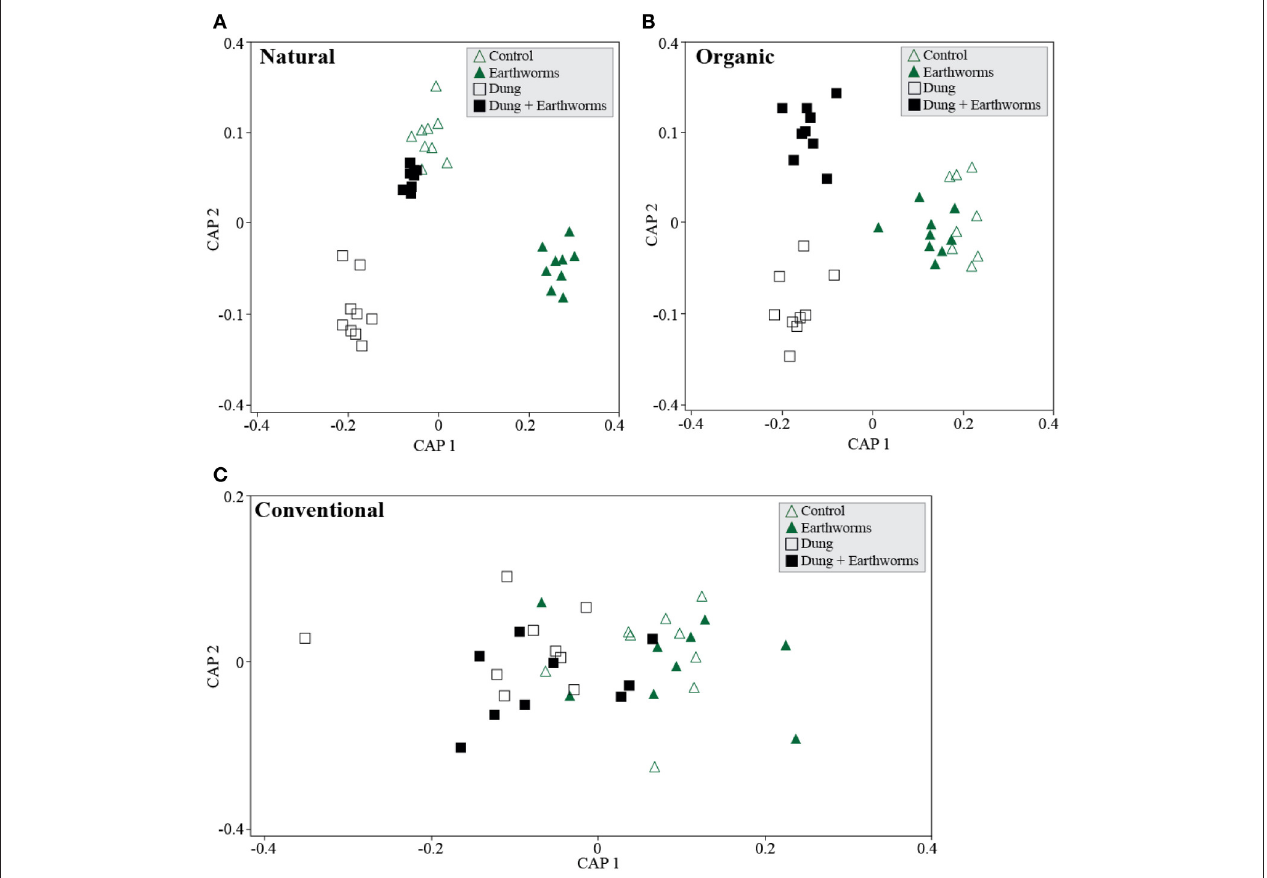
FIGURE 4 | Soil bacterial community shifts in response to treatments for each soil management regime. Canonical Analyses of Principal Coordinates based on constrained ordination by treatment for each management. (A) Natural management, first axis δ 2 = 0.98 and second axis δ 2 = 0.96, TraceQ_m’HQ_m statistic: 2.76 ( P > 0.05). (B) Organic management, first axis δ 2 = 0.95 and second axis δ 2 = 0.82, TraceQ_m’HQ_m statistic: 2.43 ( P = 0.069). (C) Conventional management, first axis δ 2 = 0.49 and second axis δ 2 = 0.09, TraceQ_m’HQ_m statistic: 0.6 ( P >